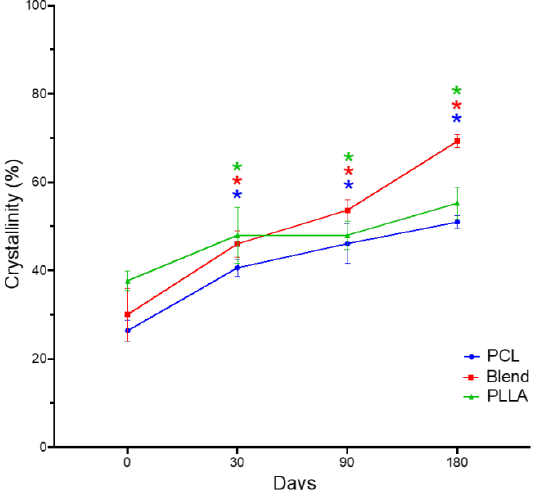
Figure 3. Percentage crystallinities determined from differential scanning calorimetry for PCL, 50:50 PCL:PLLA blend and PLLA electrospun fibers following in vitro degradation in phosphate buffered solution at 37 °C for 180 days. Statistical comparison performed with two-way ANOVA with Dunnett’s multiple comparisons test (* p < 0.05; n = 5). Stars (*) represent statistical significance compared to non-degraded scaffold (time zero).